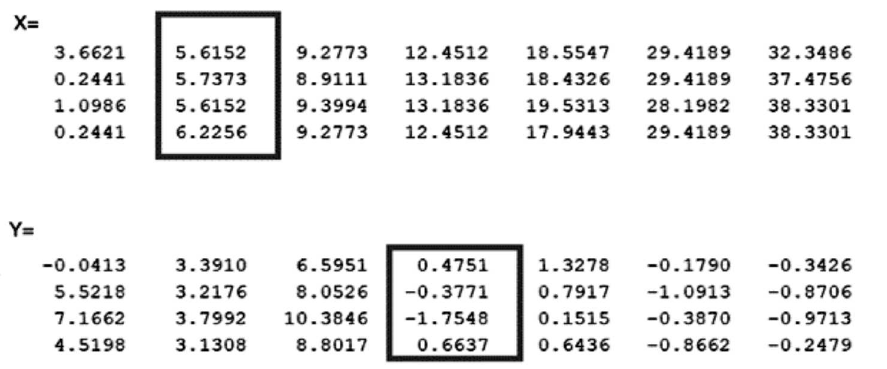
Figure 8. Matrix – low frequencies, attention disorders, sample 2